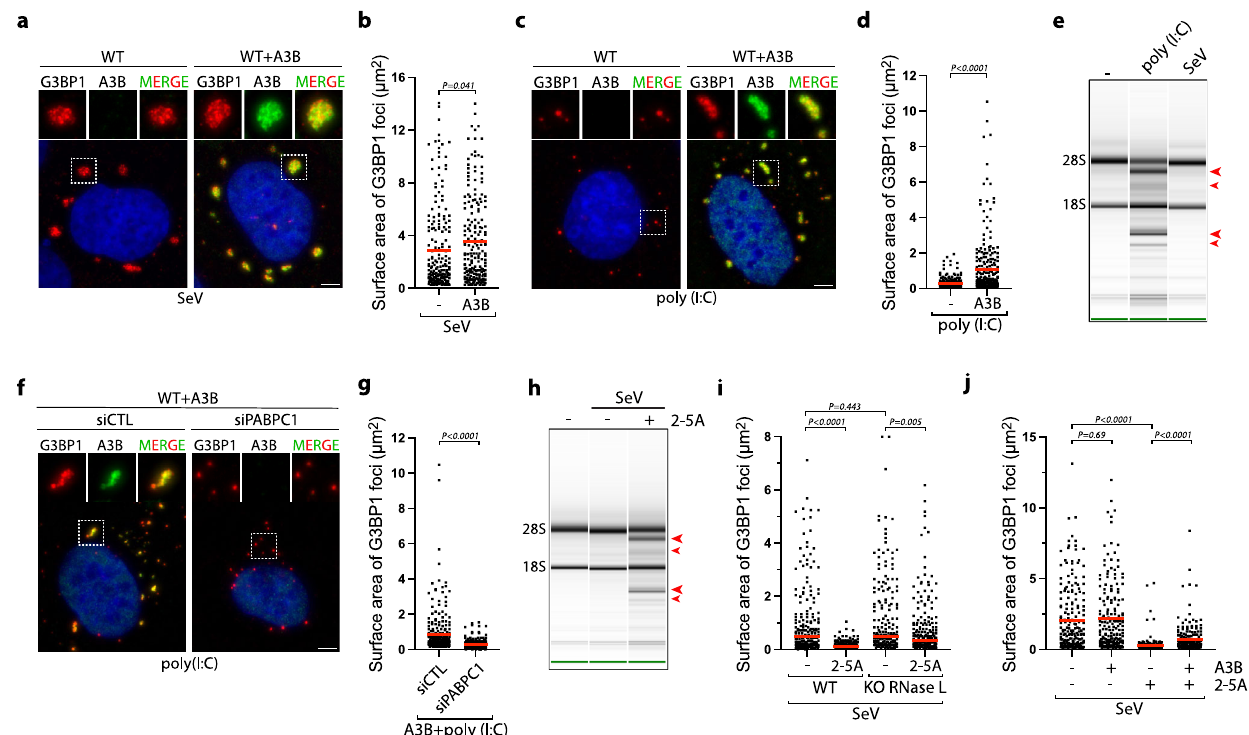
Fig. 6 | APOBEC3B prevents RNase L-mediated stress granules disassembly. a U2OS-A3B-Flag cells ± DOX were infected with SeV (MOI=1, 24hpi). A3B and G3BP1 localization were monitored by immuno fl uorescence with a fl ag or a G3BP1 antibody respectively. Scale bar: 5 μ m. b Quanti fi cation of 200 G3BP1 foci surface area from the experiment described in ( a ). Red lines indicate the mean. P -values werecalculatedwithatwo-tailedWelch t -test. c LocalizationofG3BP1andA3Bwere monitoredbyimmuno fl uorescenceinU2OS-A3B-Flagcells±DOXaftertransfection withpoly(I:C)(200ng/mL,16h).Scalebar:5 μ m. d Quanti fi cationof200G3BP1foci surface area from U2OS-A3B-Flag cells ±DOX transfected with poly(I:C) (200ng/ mL, 16h). Red lines indicate the mean. P -values were calculated with a two-tailed Welch t -test. e TotalRNAswereisolatedandmonitoredforintegritybybioanalyzer after SeV infection (MOI=1, 24hpi) or poly(I:C) transfection (400ng/mL, 8h). The red arrows indicated ribosomal RNA cleavage products. f U2OS-A3B- fl ag cells treated with DOX and knocked down with a siRNA control (siCTL) or against PABPC1 for 40h were transfected with poly(I:C) (200ng/mL, 16h). G3BP1 and A3B